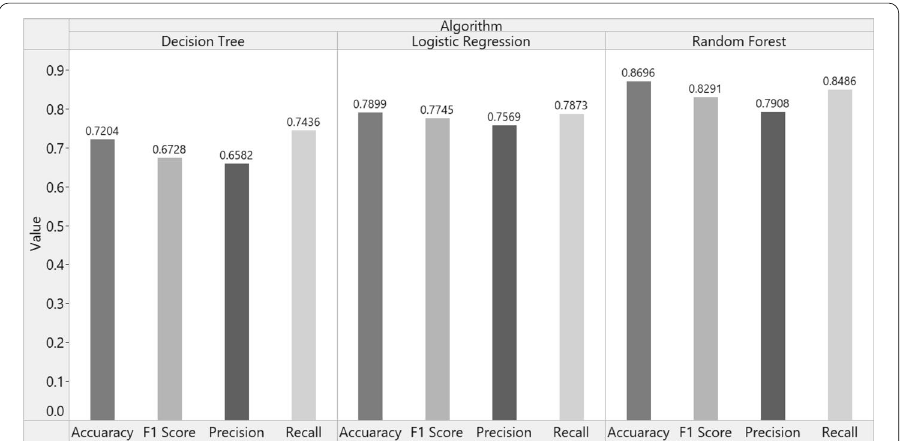
Fig. 17 Evaluation metric for binary classification on training data for ML models